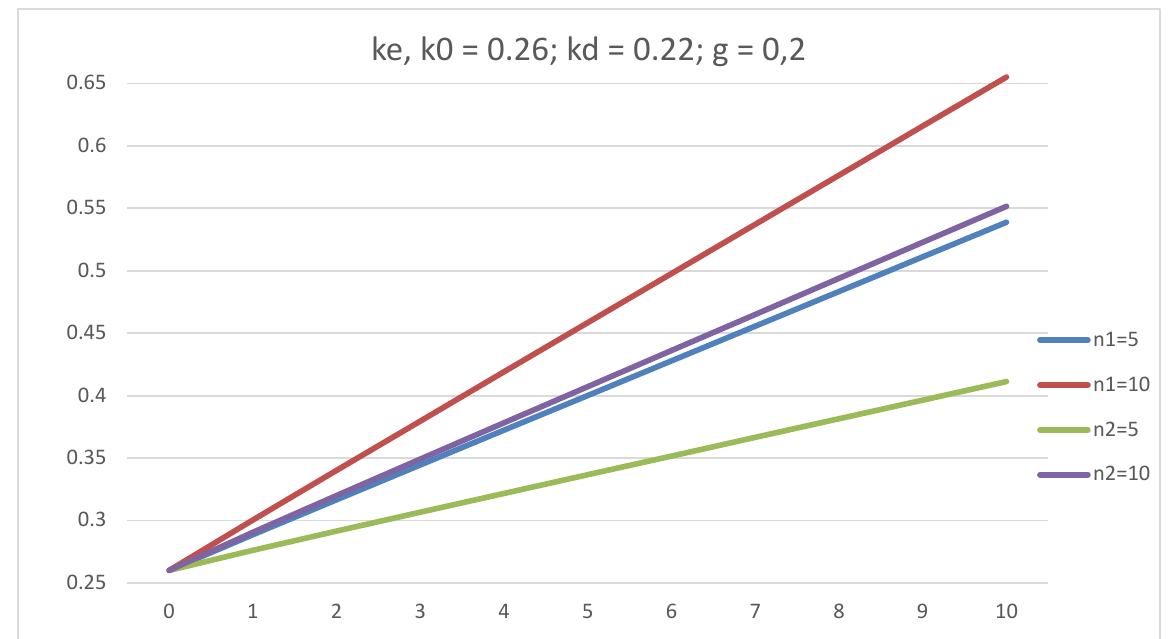
Figure 15. The dependence of equity cost, ke, on leverage level, L, in GBFO theory with payments of tax on profit at the end of periods (1) and advance payments (2) at k 0 = 0.26; k d = 0.22; t = 0.2; g = − 0.2, for five-year and ten-year companies.